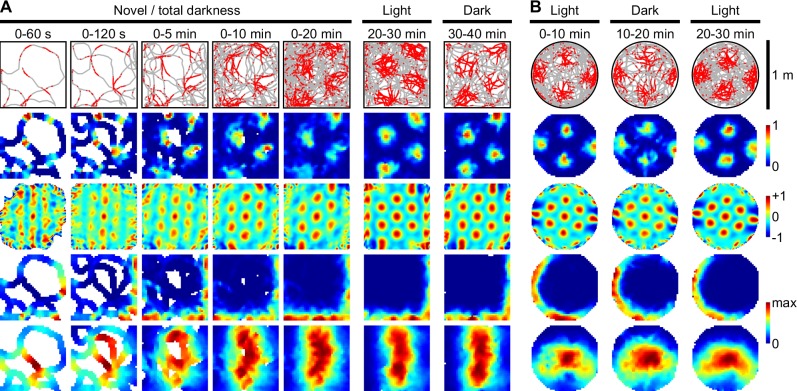
Rapid emergence and persistence of stable grid and boundary fields in darkness.(A) Stable probabilistic grid cell response (rows 1 to 3) in a 1 m square arena, in darkness and initially disoriented (Novel / total darkness), and during subsequent light (Light) and dark (Dark) sessions, matches rat grid cell data (Fig S7b of [10]). Predictive boundary fields (row 4 –short-range, row 5 –long-range) are also immediately stable in darkness. (B) Probabilistic grid and boundary fields persist in darkness in a 1 m circular arena (∞-fold rotational symmetry), matching rat grid cell data (Fig S7a of [10]).